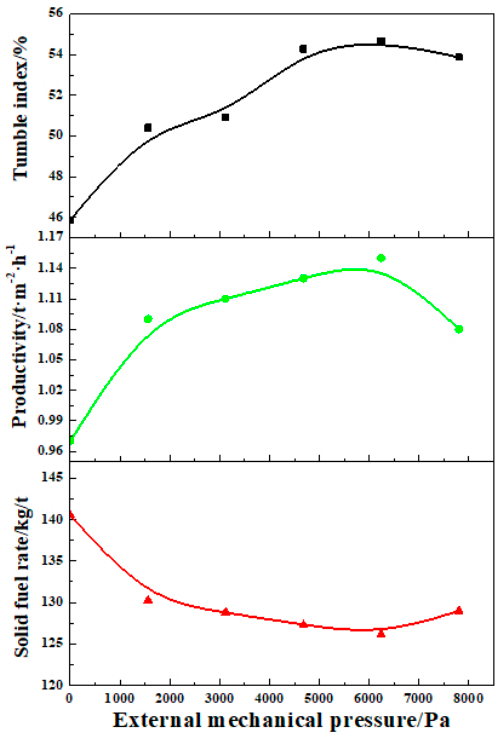
Figure 3. Sintering performance of limonitic laterite under various external mechanical pressure. Table 2. The detail varying of sinter indices of limonitic laterite with external mechanical pressure. Pressure (Pa)